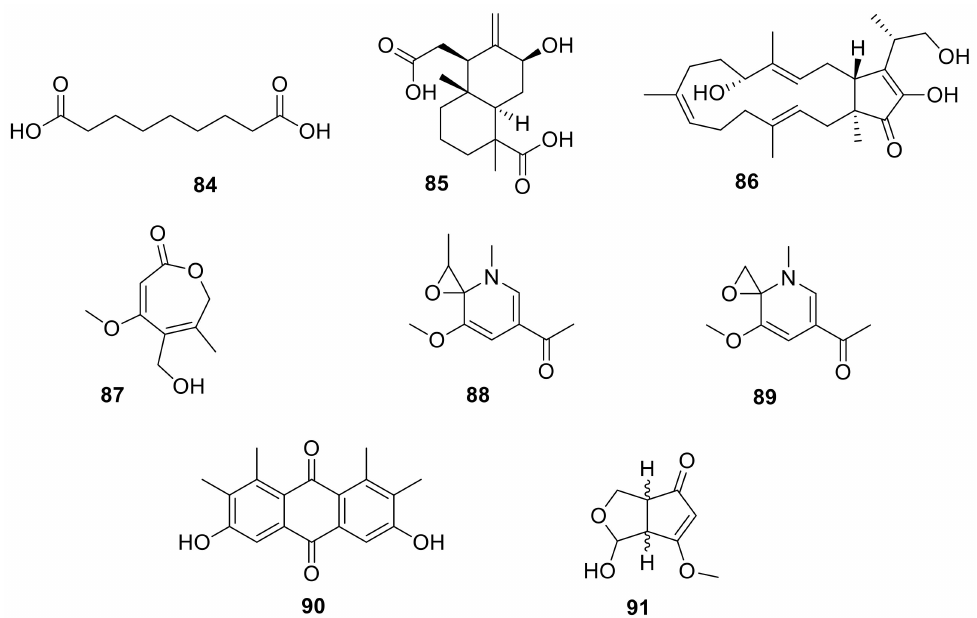
Figure 10. Structures of compounds from the group “miscellaneous”: azelaic acid, 5-(carboxymethyl)-7-hydroxy-1,4a- dimethyl-6-methylene decahydronaphthalene-1-carboxylic acid, ( − )-terpestacin, luteoxepinone, luteoethanones A-B, lu- teoethanone B, neoanthraquinone, ( ± )-nigrosporione ( 84 – 91